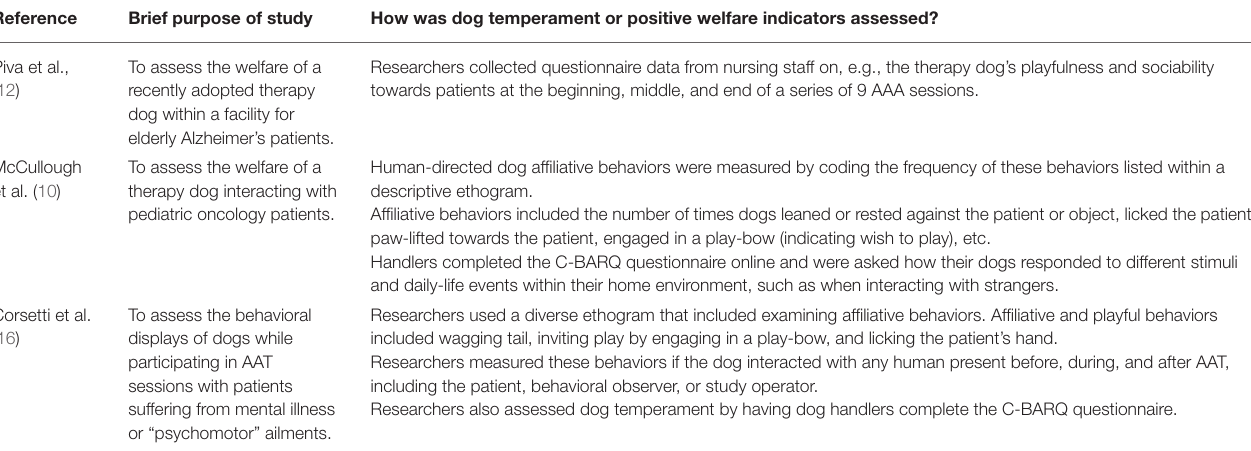
TABLE 1 | Therapy dog welfare literature examining dog temperament or human-directed dog affiliative behaviors.